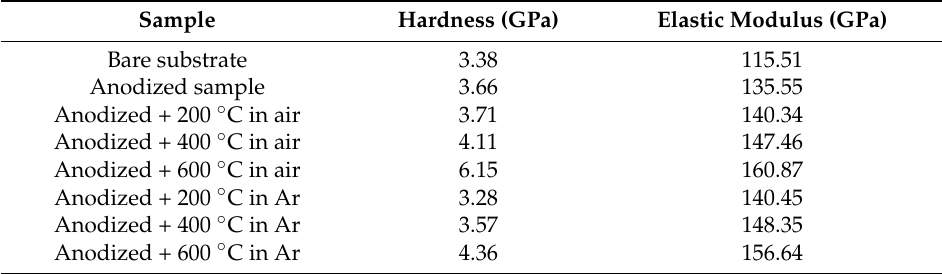
Table 4. Hardness and elastic modulus of different samples—Nanoindentation